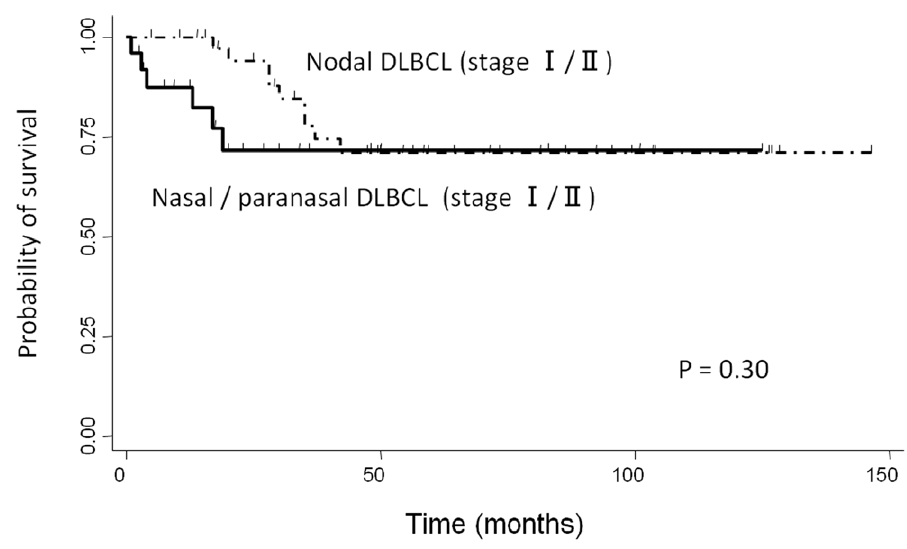
Figure 4. Comparison of overall survival between localized nasal/paranasal DLBCL and localized nodal DLBCL.